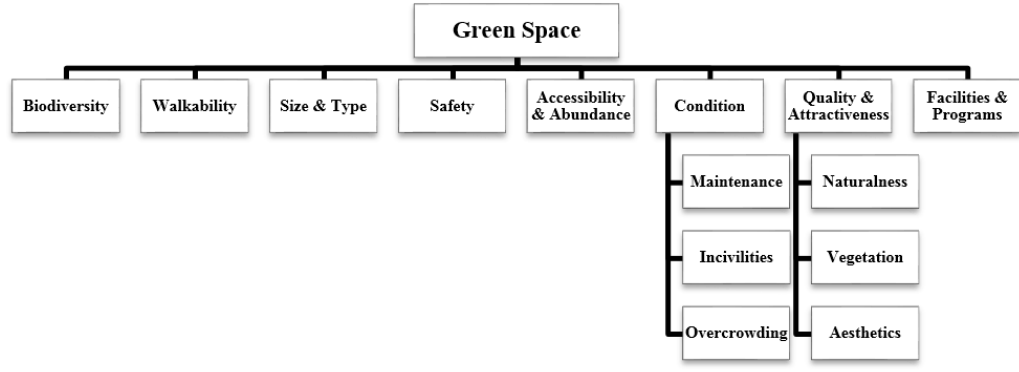
Figure 9: Individual